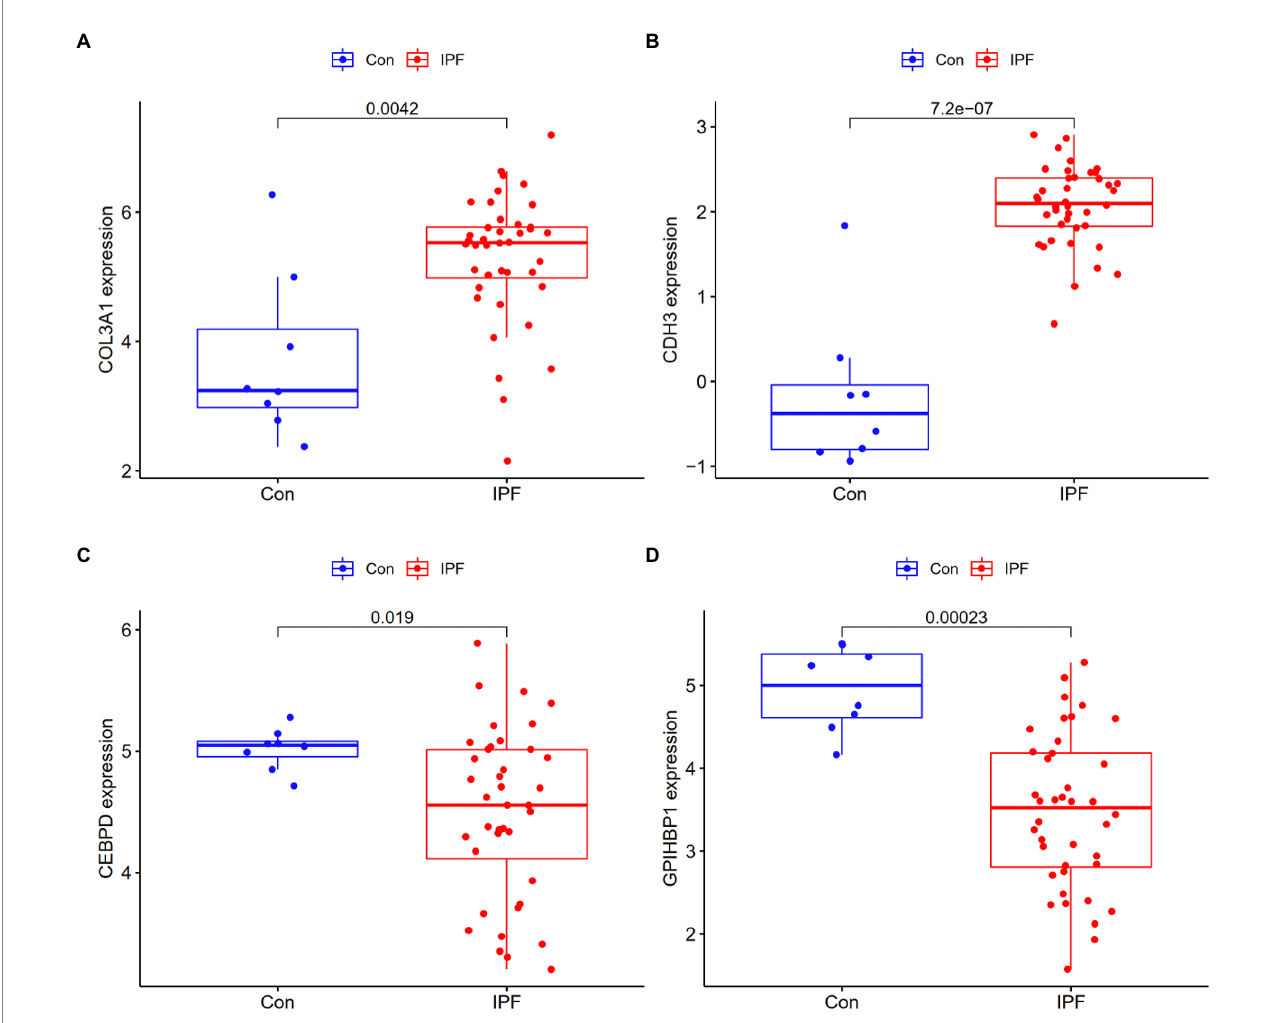
FIGURE 4 Validation of the expression of candidate genes in the GSE53845 dataset. (A) The expression of COL3A1 was higher in the lung tissues of patients with IPF (IPF) than in those of healthy individuals (Con). (B) The expression of CDH3 was higher in the lung tissues of patients with IPF than in those of healthy individuals. (C) The expression of CEBPD was lower in the lung tissues of patients with IPF than in those of healthy individuals. (D) The expression of GPIHBP1 was lower in the lung tissues of patients with IPF than in those of healthy